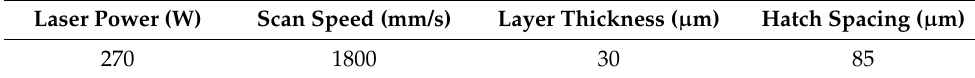
Table 2. L-PBF processing parameters for fabrication of Ti64